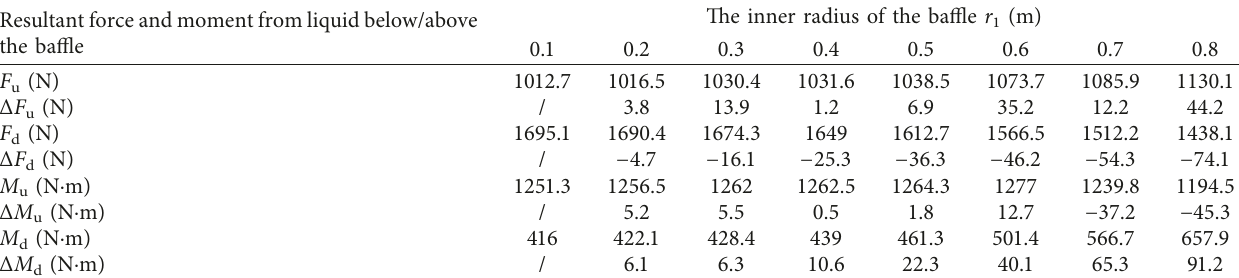
Figure 15: Wall-pressure distributions ( θ � 0) corresponding to the maximum amplitudes F 0.4m, 0.6 m, and 0.8m, respectively. Table 4: The resultant hydrodynamic force and moment from liquid below/above the baffle versus the inner radius of the baffle for � 0 . 5 z 1